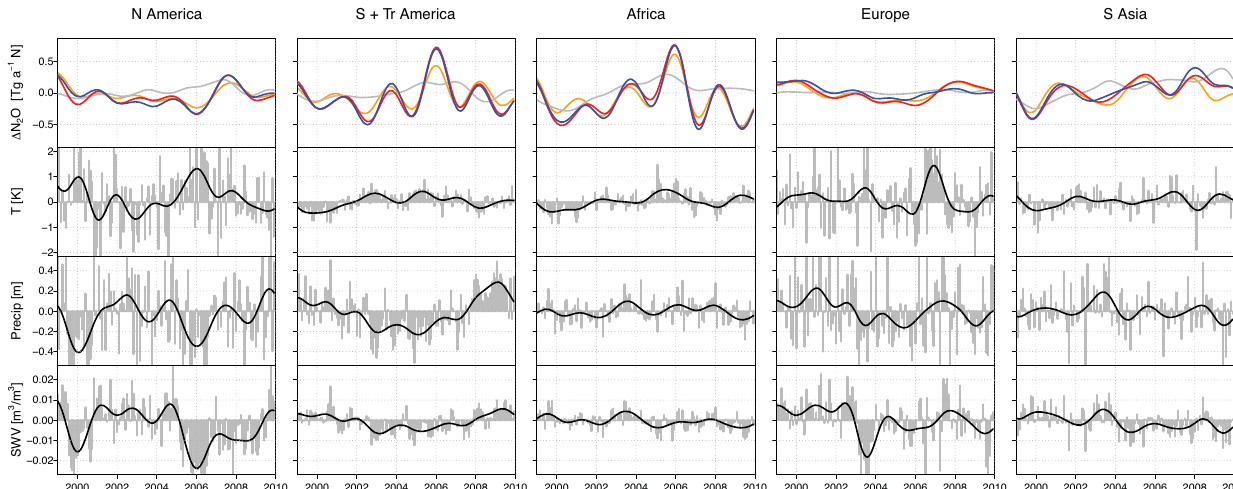
Fig. 10. Comparisons of the interannual variability in N 2 O flux with anomalies in soil temperature ( T ), precipitation (Precip) and soil water volume (SWV) (ECMWF ERA-Interim). For the fluxes, the legend is the same as in Fig. 7. For the meteorological variables, the grey bars indicate the monthly anomaly and the solid line the interannual